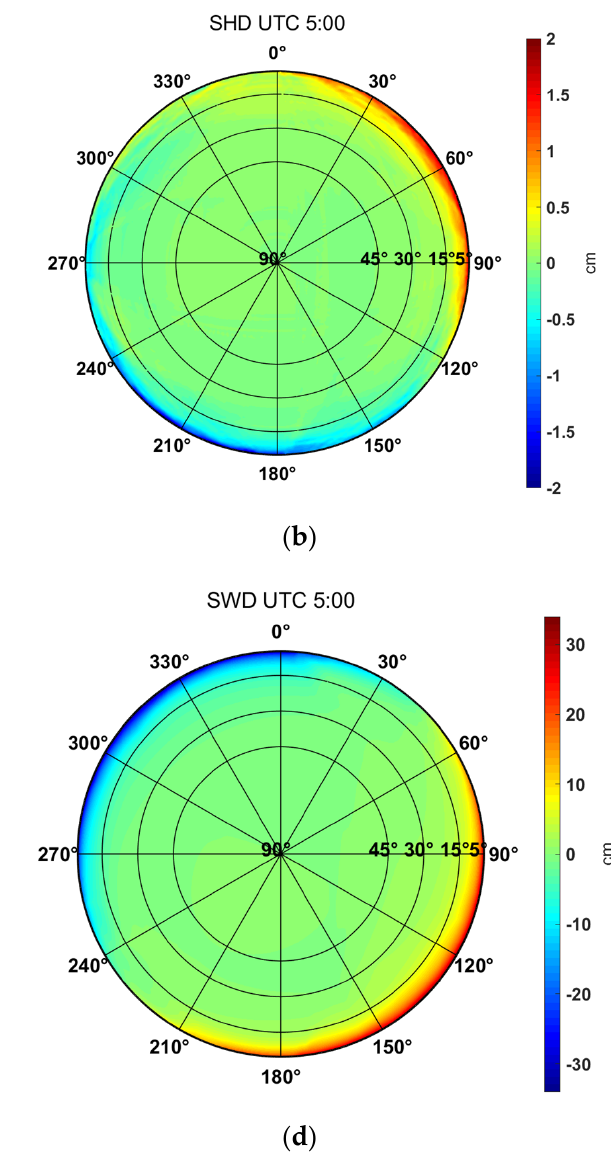
Figure 7. The asymmetry of ray-tracing slant delays calculated by removal of the mean value of each elevation on all azimuths, for the IGS station SHAO located in Shanghai on 21 July 2018 ( a ) SHDs at 00:00 UTC, ( b ) SHDs at 05:00 UTC, ( c ) SWDs at 00:00 UTC, ( d ) SWDs at 05:00 UTC. Please note the difference between the bound of the colour bar on the right side of each subfigure.